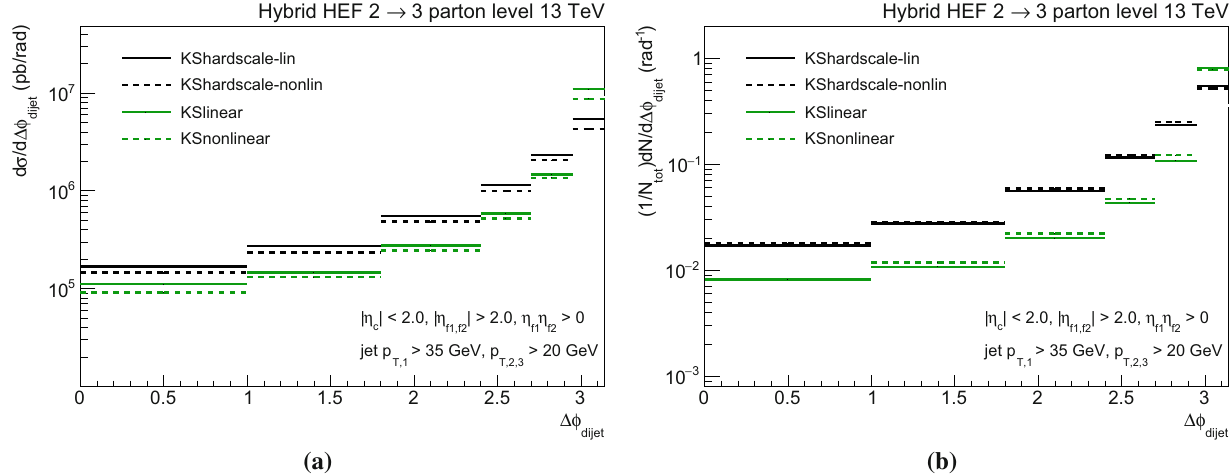
Fig. 1 Comparison of 2 → 3 parton level predictions using the hybrid framework with KS PDFs with (black lines) and without (green lines) Sudakov resummation. Shown in absolute cross sections ( a ) and normalised distributions ( b )